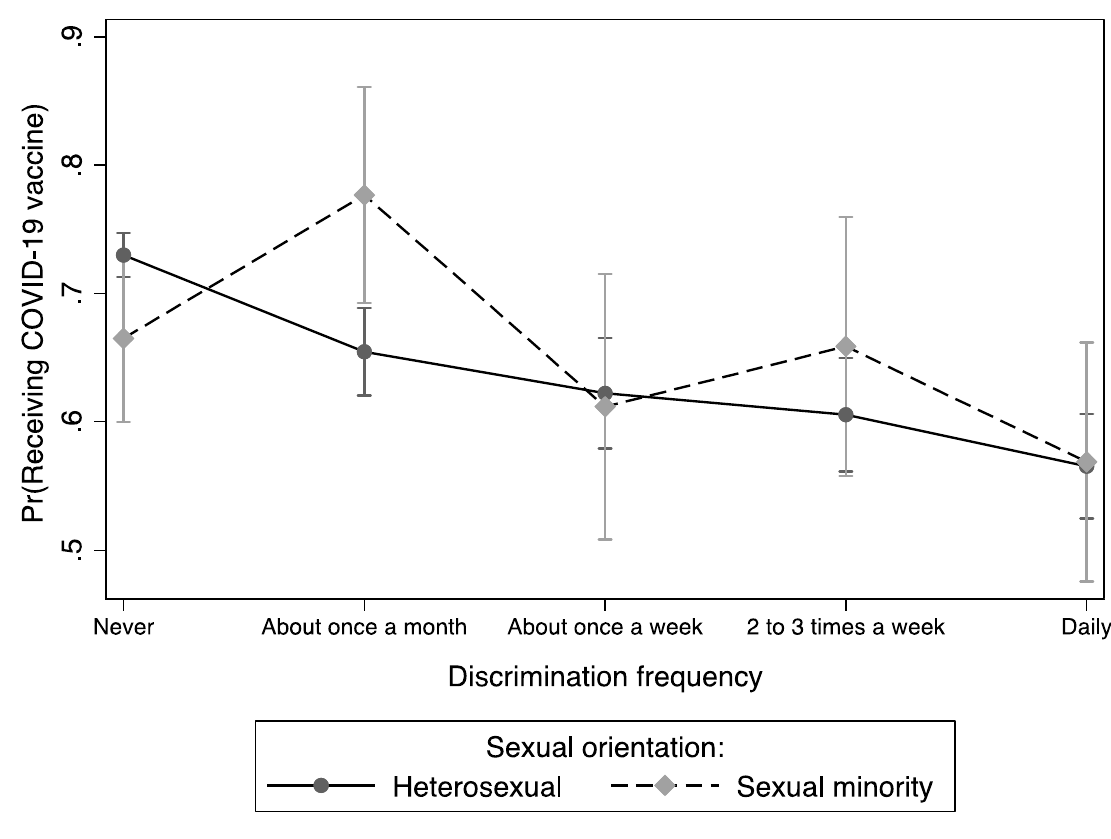
Figure 4. Differences in the perceived likelihood of receiving the COVID-19 vaccine between and within sexual orientation and discrimination frequency during the pandemic. Table 2. Multivariable logistic regression analysis of the associations between the likelihood of receiving a COVID-19 vaccine and sociodemographic characteristics, the fear or likelihood of con- tracting COVID-19, anxiety/depression, discrimination, and social distancing stress across sexual identity